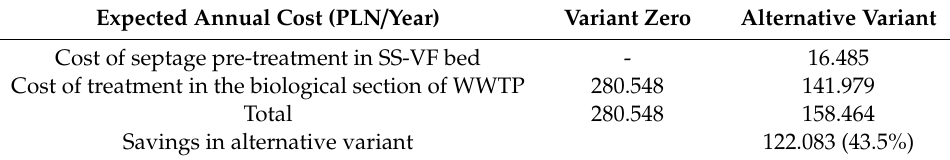
Table 2. Example 2—comparison of costs in variant zero and in alternative variant.